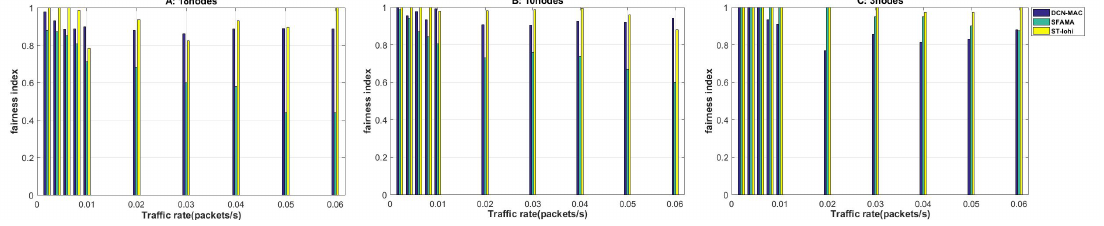
Figure 9. The fairness index of the network at different packet generation rates when the number of nodes is 3, 10, and